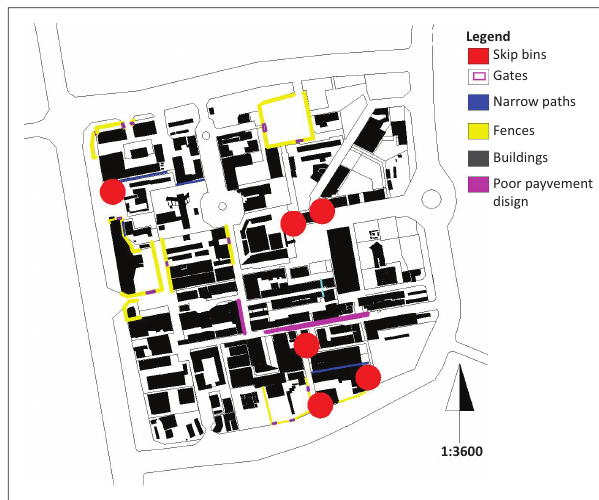
FIGURE 5: Open spaces and parking spaces. FIGURE 6: Street obstacles in the central business